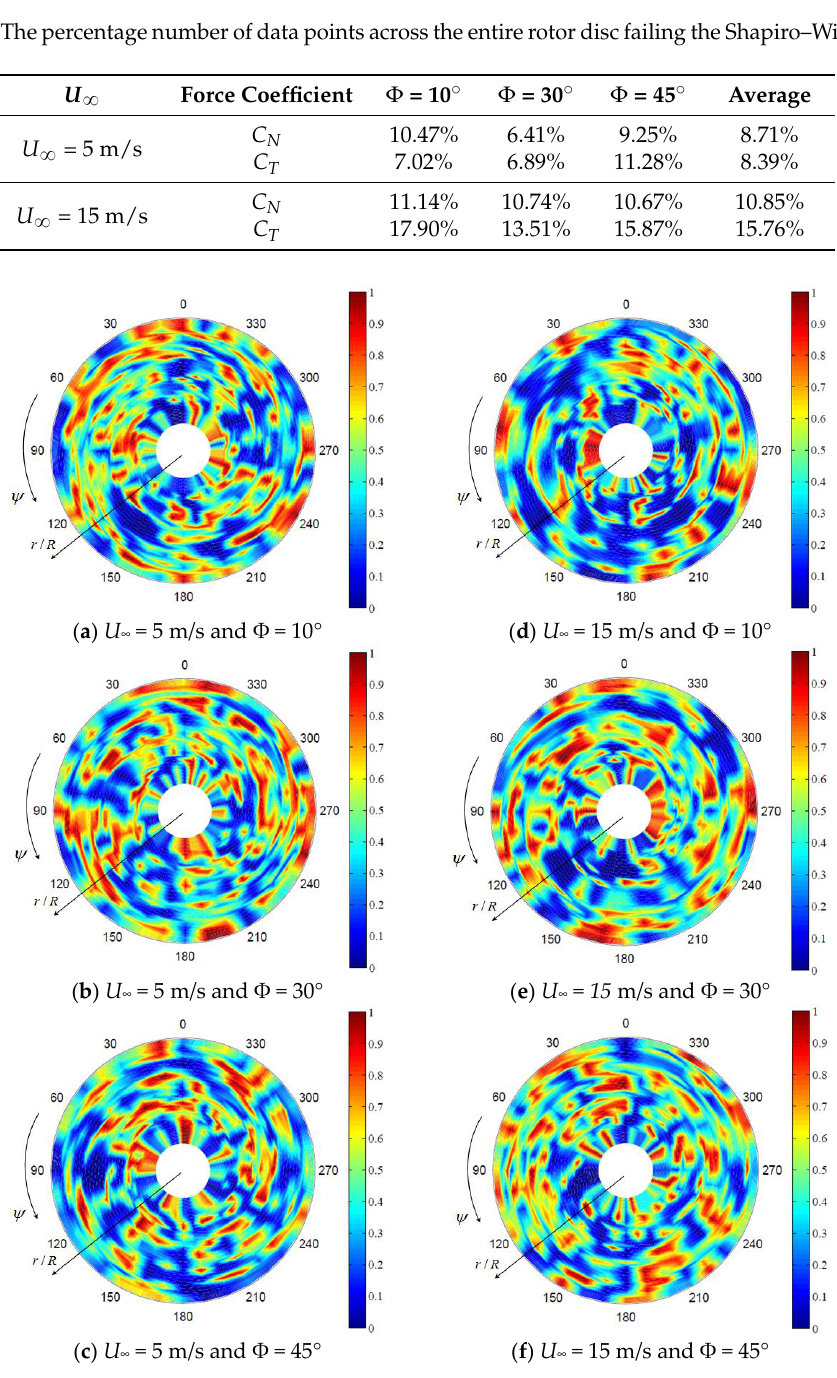
Figure 14. Illustration for the locations of the normally and non-normally distributed C N data bins. Different colors and the bar indicate the probability (p- value) determined using Shapiro–Wilk’s test. p- value > 0.05 indicates that data are normally distributed.